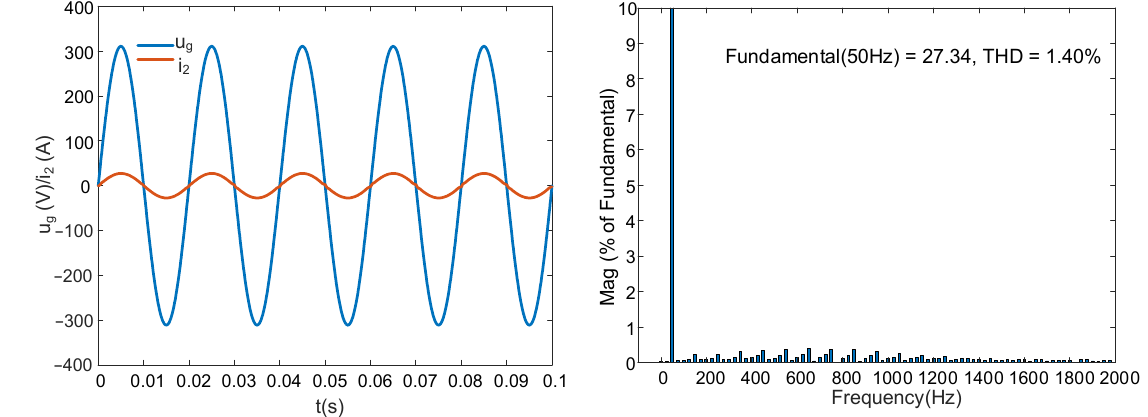
Figure 13. Simulation results of the “IOGCI + FOPI” system. For the FOGCI, the inductor order α = 1.2 and the capacitor order β = 0.8 ( α + β = 2). The capacitor current feedback coefficient H i 1 = 0.1. First, the IOPI controller was used to regulate the grid current; the results are shown in Figure 14. The system was stable, the RMS value of i 2 was 27.34 A, and the THD was 1.40%. Then, the FOPI was employed to control the grid current, and the integral order λ = 0.9; the simulation results are shown in Figure 15. The system was stable, too, as the RMS value of i 2 was 27.30 A and the THD was 0.94%.